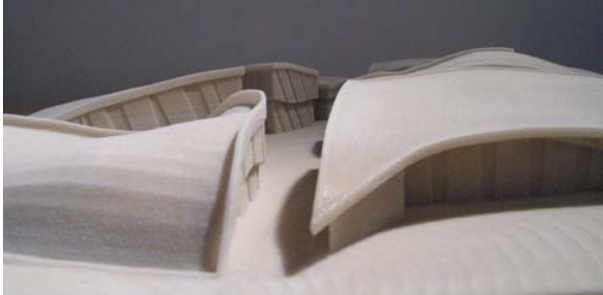
Figure 8. Solid model - 3D printed